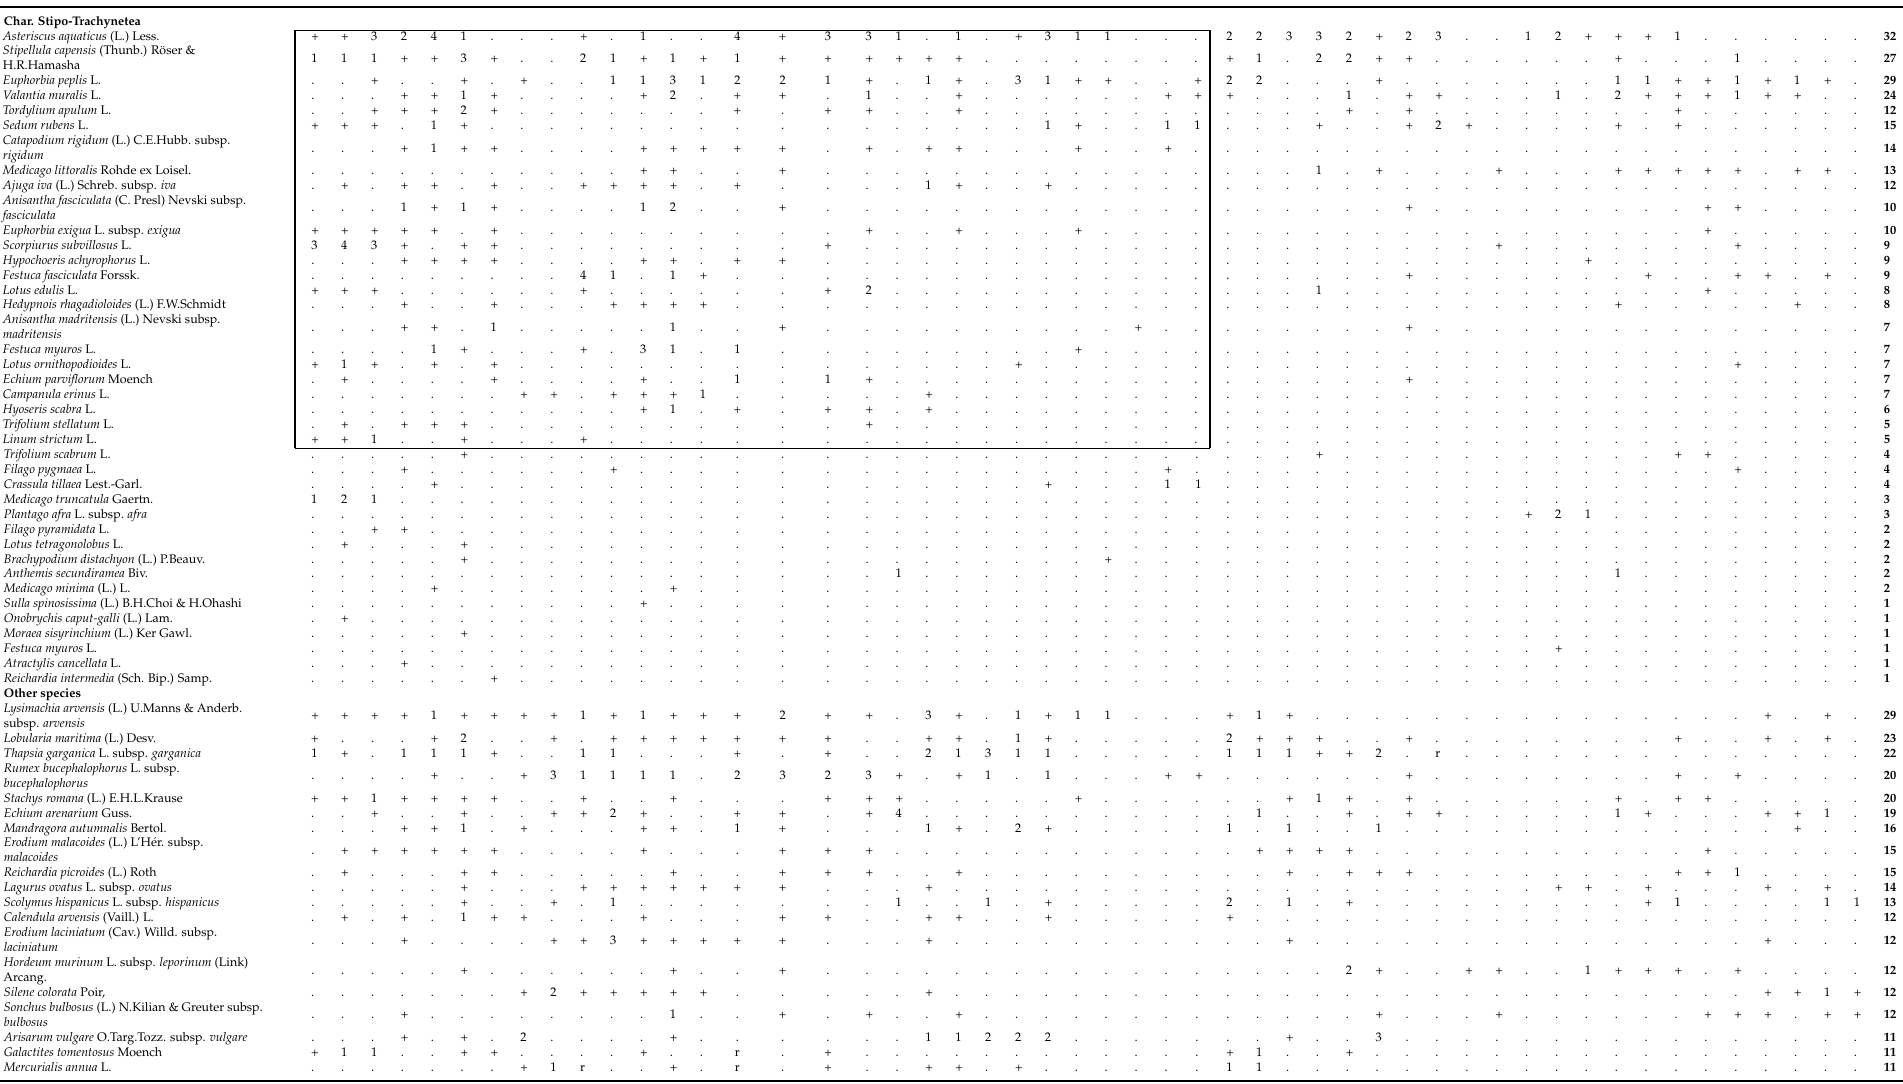
Char. Stipo-Trachynetea Asteriscusaquaticus (L.)Less. + + 3 2 4 1 .